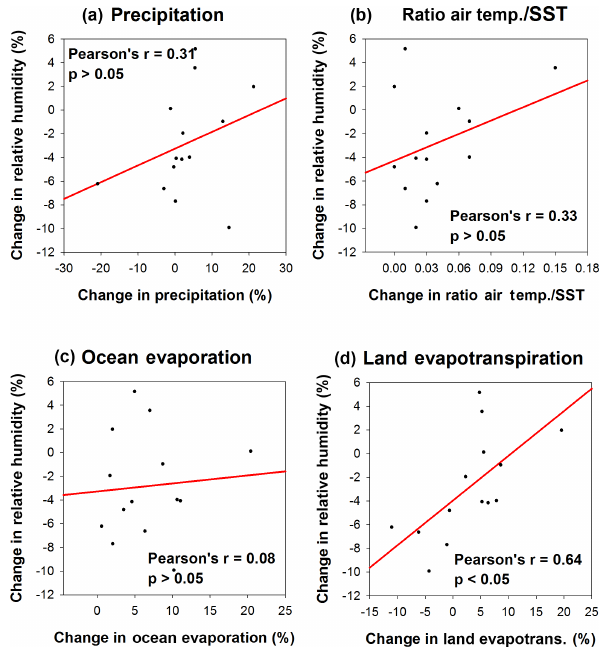
Figure 11. Relationships between the average annual magnitudes of change in RH identified for each one of the 14 analyzed regions and the annual magnitudes of change in precipitation, the ratio be- tween air temperature and SST, oceanic evaporation, and land evap-